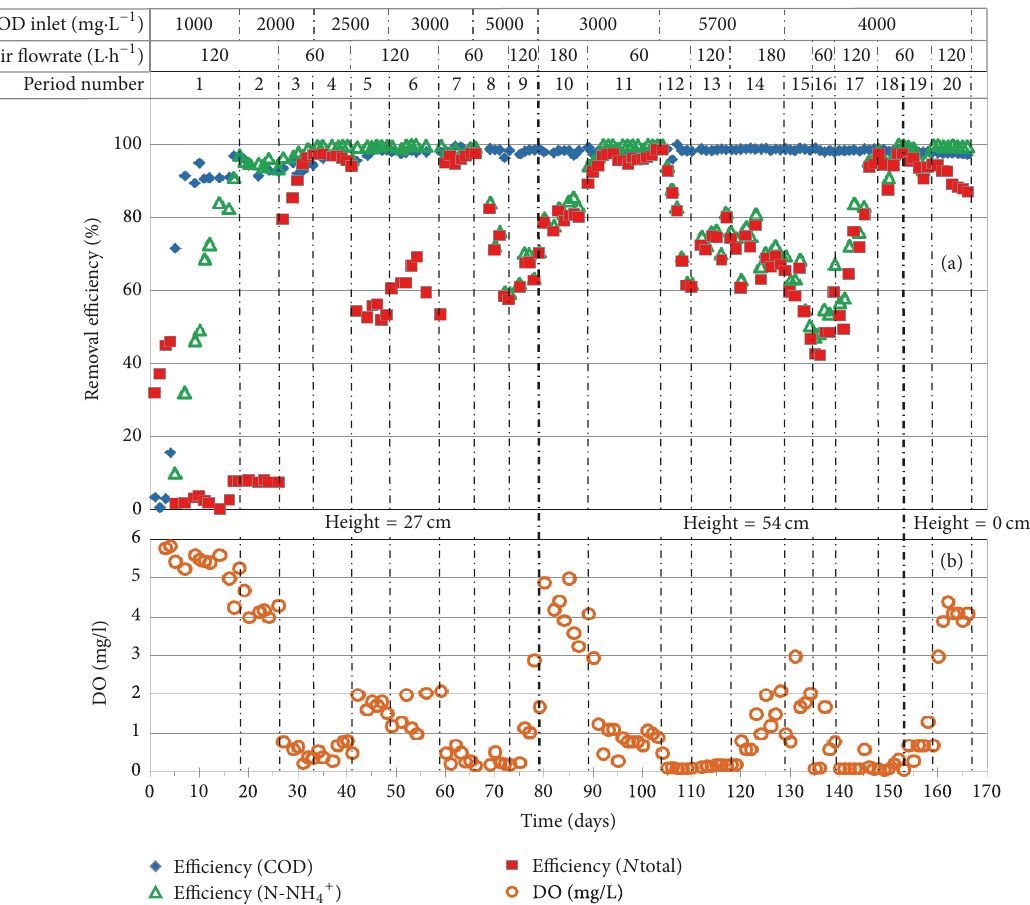
Figure 3: Removal efficiencies for a COD; N-NH 4+ ; 𝑁 total; and (b) DO concentrations as a function of